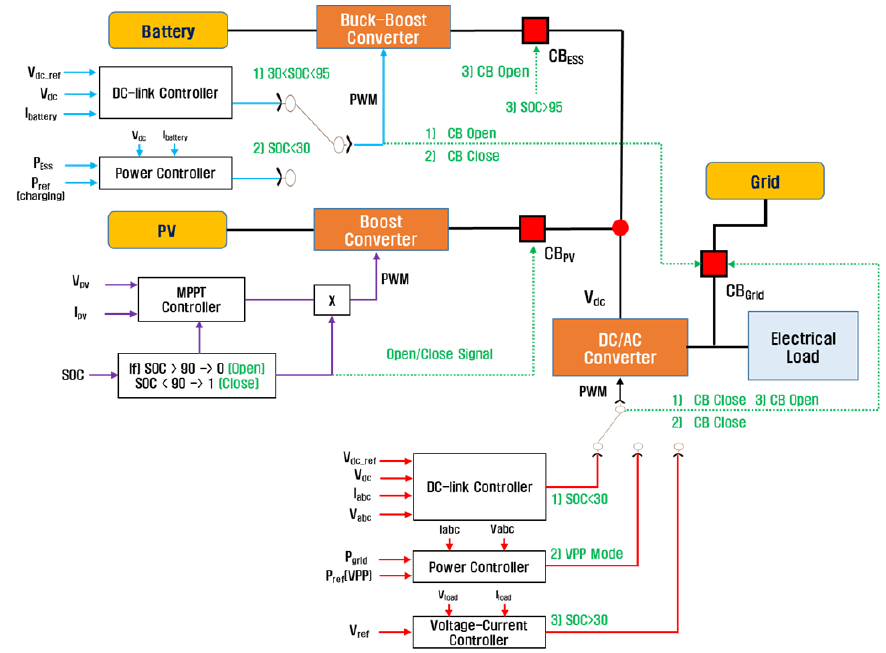
Figure 6. The overall implementation block diagram for the proposed scheme.